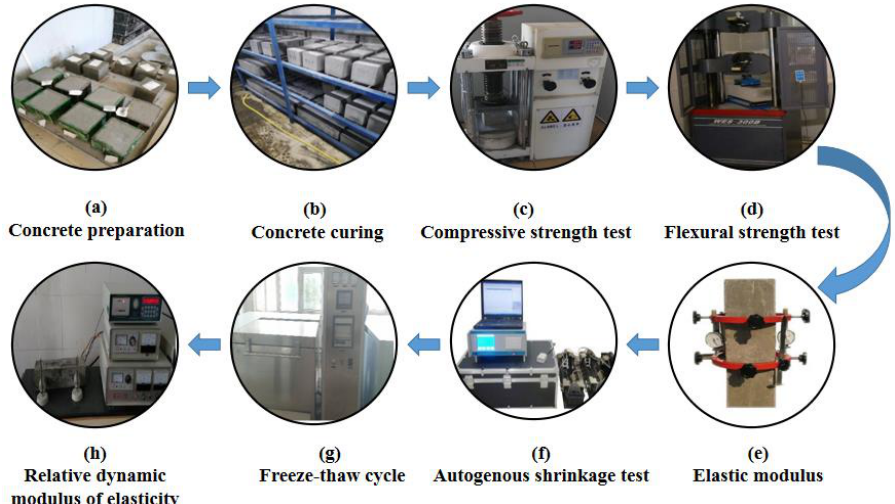
Figure 2. The process of the main test.